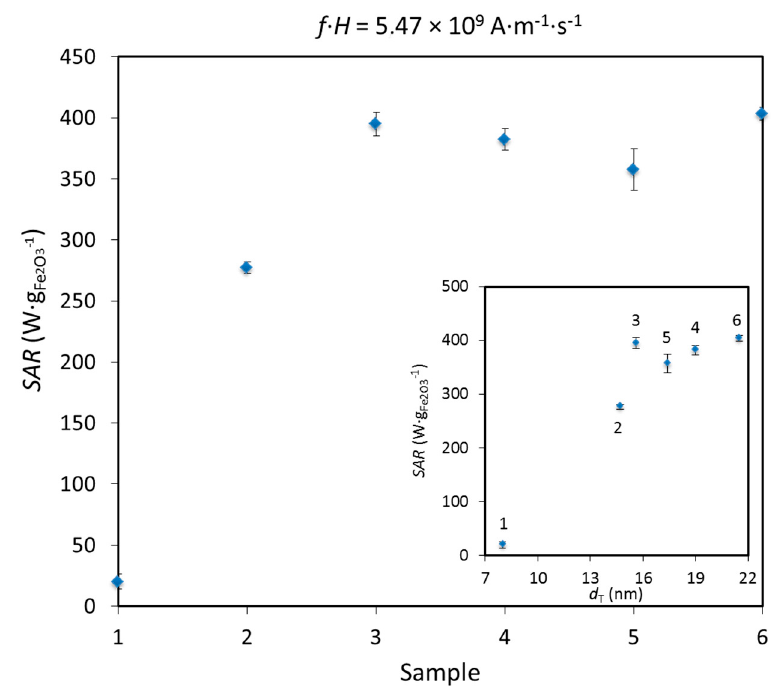
Figure 7. SAR as a function of the sample’s number to observe the evolution of SAR with the prolonged HT duration of IONPs at the field parameters the closest to the clinical limit of the f · H product. The insert shows SAR as a function of d T at the same field parameters. The error bars indicate standard deviation.